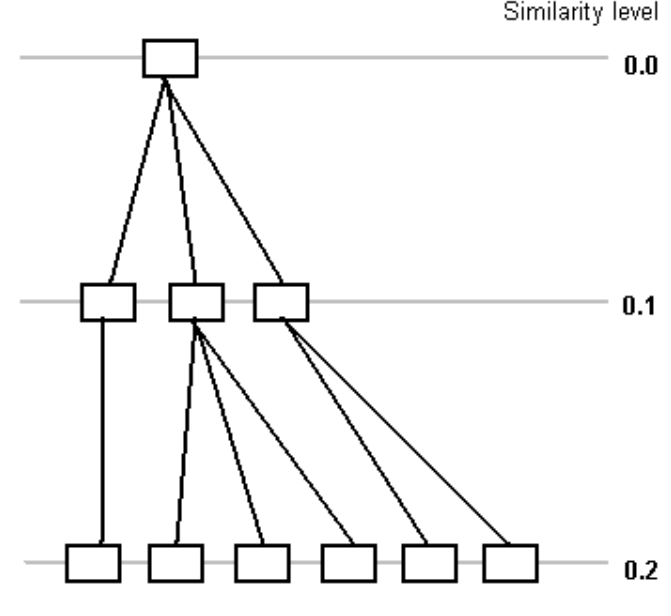
Figure 3. Divisive clustering with Rd =0.1 (10-step